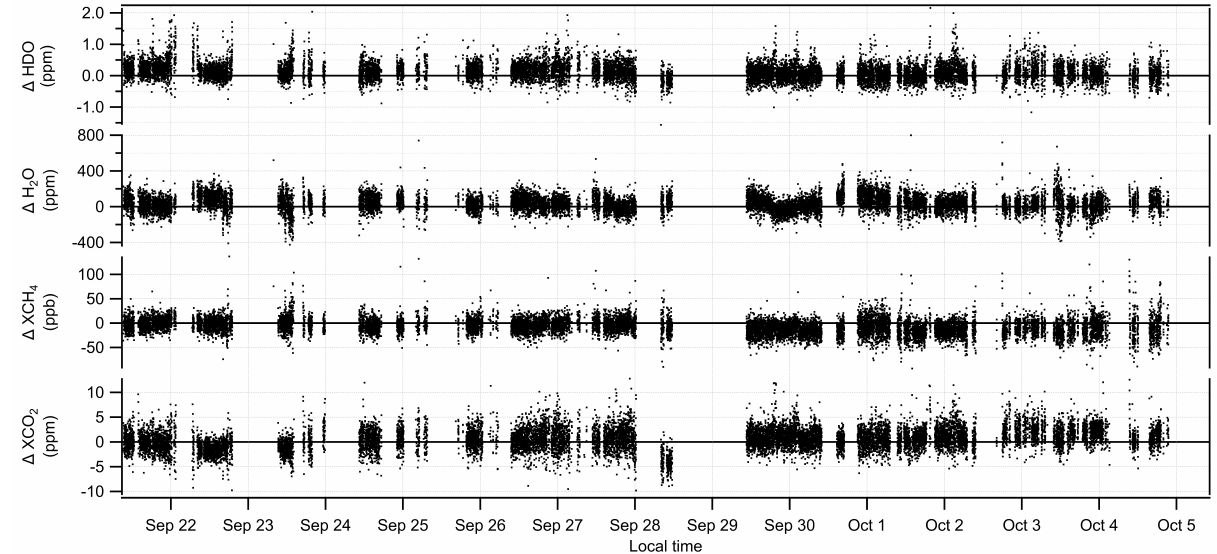
Figure 6. Time series of concentration differences, where difference is defined as DCS A minus DCS